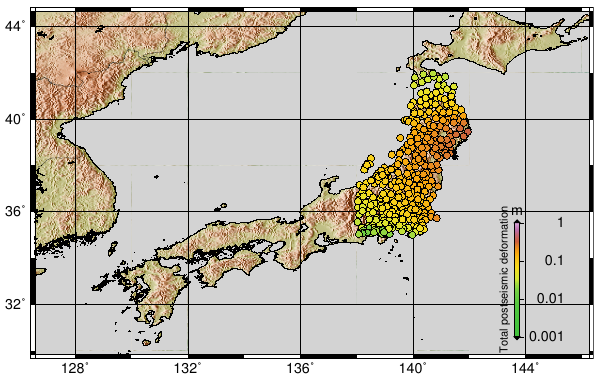
Figure 3. Postseismic slip distribution (Ozawa et al., 2011). Dis- placement in meters. Dynamical range of data clearly shown from the color distribution of circles running at least 4 orders of magni-